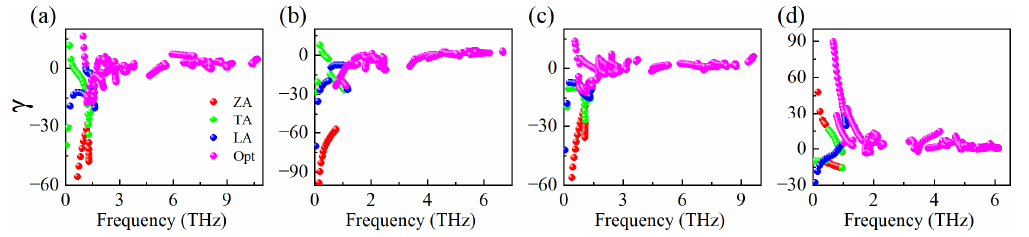
Figure 7. The Grüneisen parameters γ for monolayer: ( a ) CuSbS 2 ; ( b ) CuSbSe 2 ; ( c ) CuBiS 2 ; and ( d ) CuBiSe 2 .